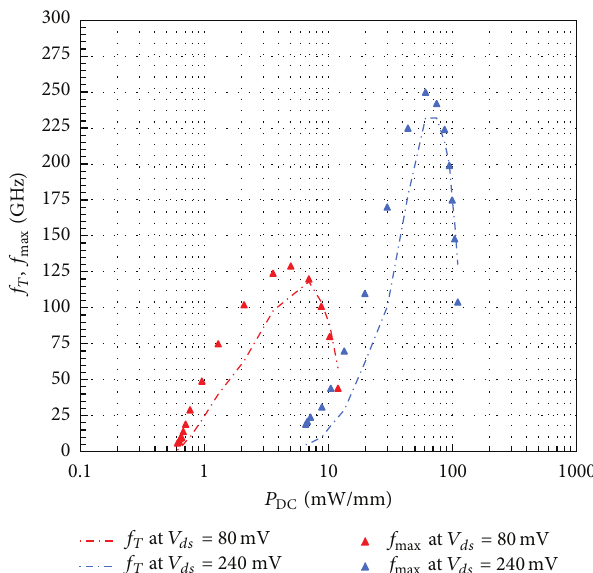
Figure 5: Extrapolated ( 𝑓 𝑇 , 𝑓 max ) plotted as a function of DC power consumption calculated as 𝑉 𝑑𝑠 × 𝐼 𝑑𝑠